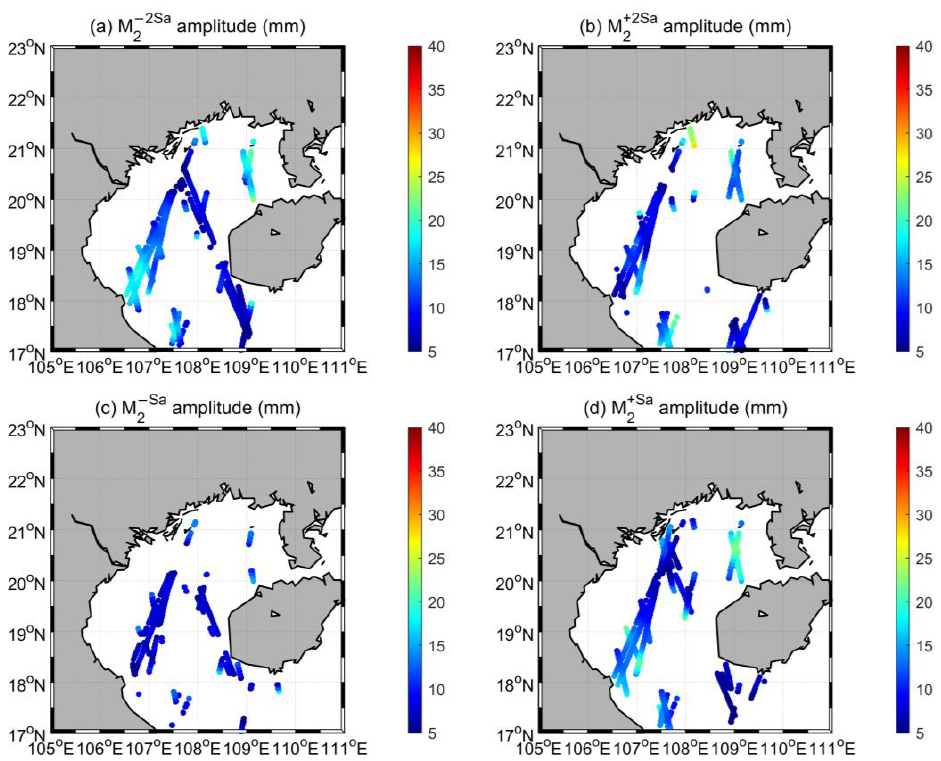
Figure 8. Estimated tidal amplitudes (unit: mm) in the Gulf of Tonkin from multi-satellite altimeter observations ( a ) M 2 − 2Sa ( b ) M 2+2Sa ( c ) M 2 − Sa ( d ) M 2+Sa